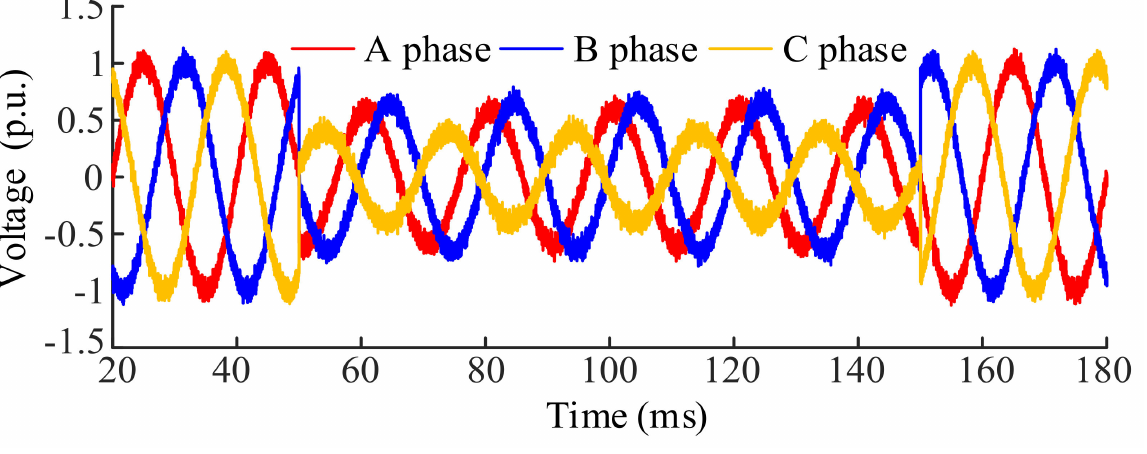
Figure 10. Three-phase unbalanced voltage sag drop